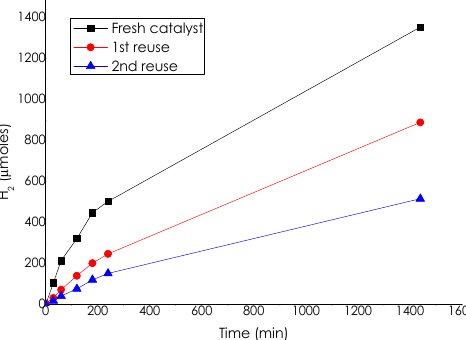
Figure 6. Temporal H 2 evolution upon reuse of Pd / CS catalyst either fresh or reused (once or two)